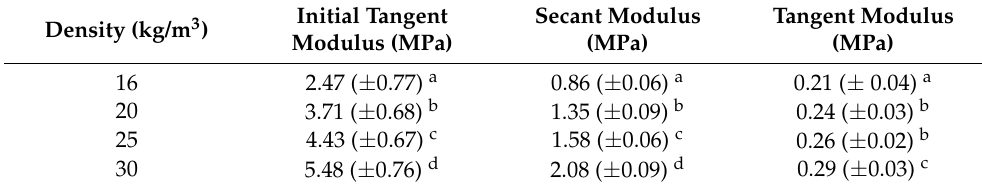
Figure 6. SEM images for several conditions: EPS20. ( a ) Intact specimen. ( b ) Compression up to ε = 0.5. ( c ) an applied load (0.0791 MPa) for 12 h. Table 3. Various elastic moduli of EPS, for different density levels.